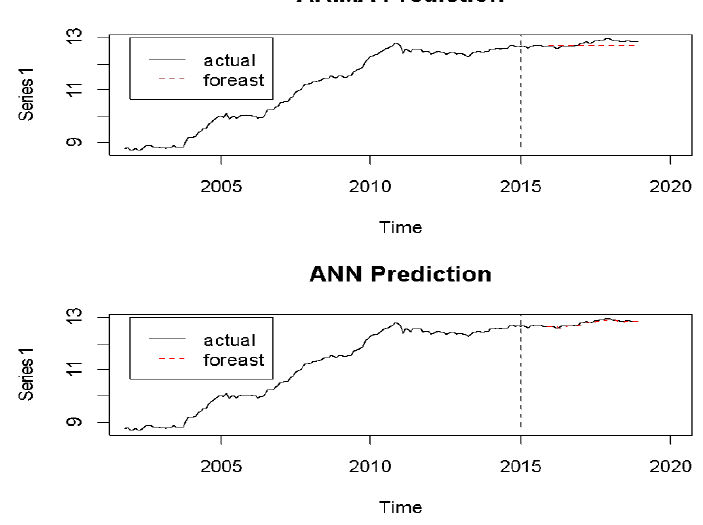
Figure 7. The forecasted pattern of ARIMA and ANN model